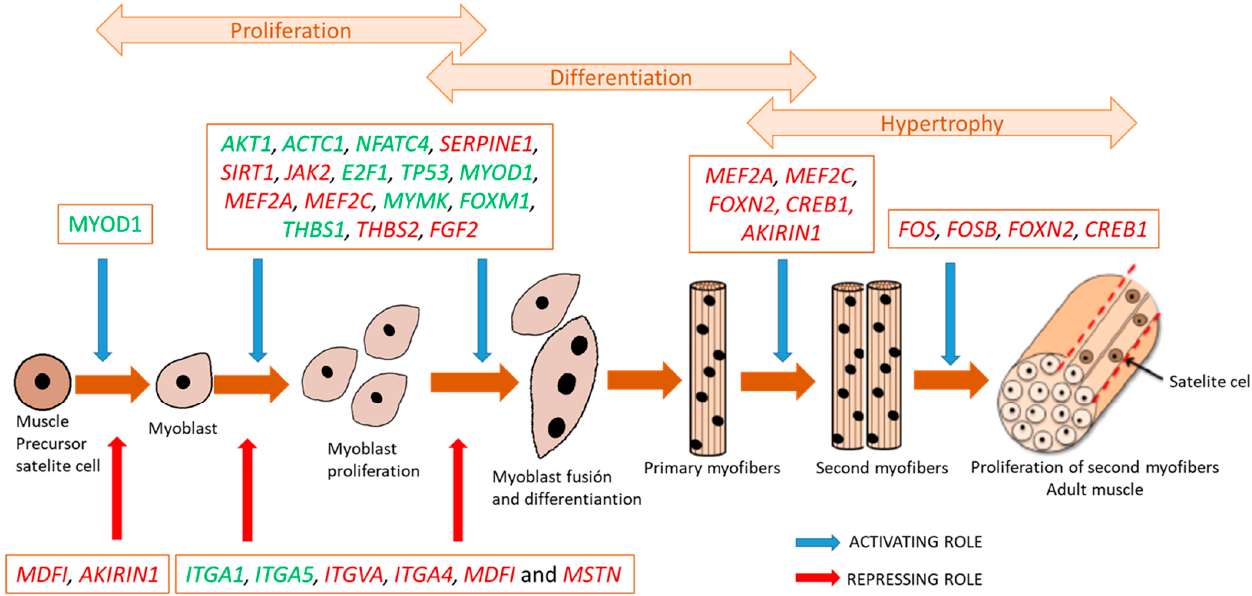
Figure 2. DEGs implicated in myogenesis. Genes in green color are upregulated in transition piglets and genes in red color are upregulated in growers.